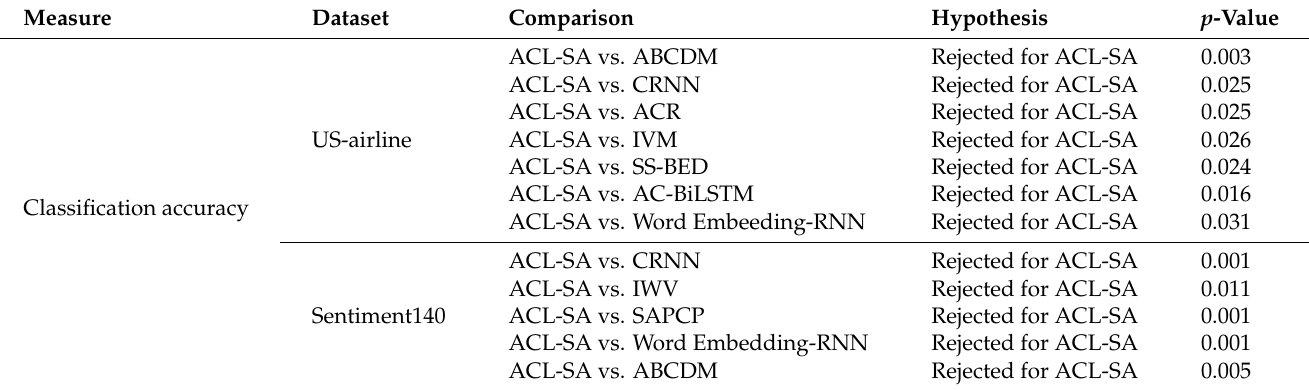
Table 8. Wilcoxon tests of different sentiment analysis methods in terms of classification